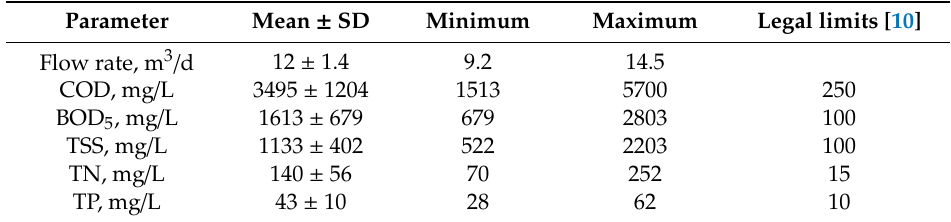
Figure 2. The study area: ( A ) production area; ( B ) zootechnical wastewater generation and conveying. Table 1. Zootechnical wastewater characteristics in terms of flow rate and main chemical parameters (biological oxygen demand (BOD5), chemical oxygen demand (COD), total suspended solids (TSS), total nitrogen (TN) and total phosphorus